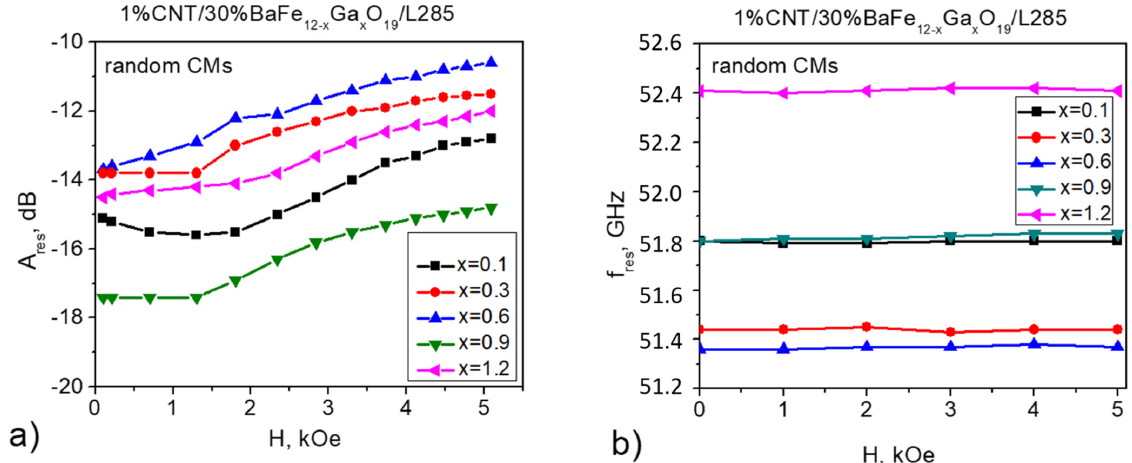
Figure 4. FMR amplitude ( a ) and frequency ( b ) as a function of the applied external magnetic field measured for random 1% CNT/30% BaFe 12– x Ga x O 19 /L285 composites.